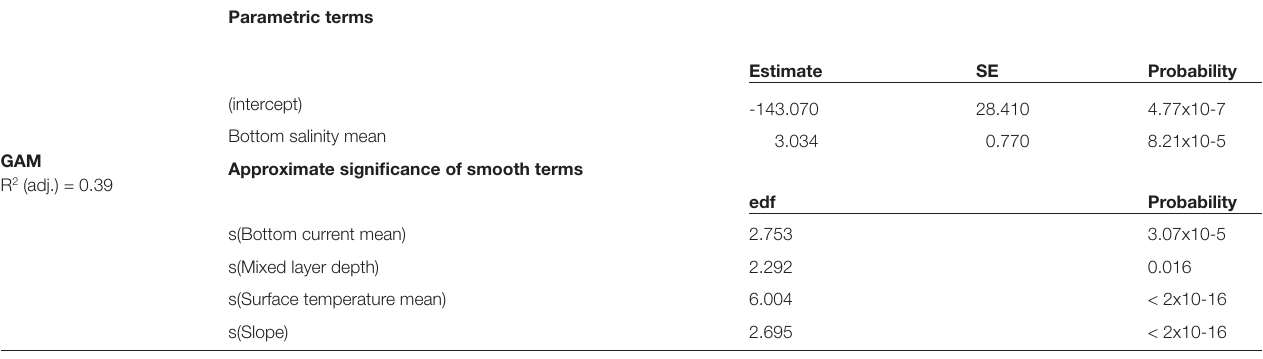
FIGURE 5 | Probability of occurrence of Paragorgia arborea from RF models (A–D) and GAMs (E–H) under present-day (A, E) , RCP 4.5 (C, G) and RCP 8.5 (D, H) , as predicted by models constructed using 8 environmental predictors, with model uncertainty for present-day predictions (B, F) generated from the standard deviation created from 5-fold spatial block cross-validation. Areas of model extrapolation are shown on each map as a transparent overlay and were created using both presence and absence data. TABLE 1 | Parametric coefficients and approximate probability of smooth terms in the GAMs.